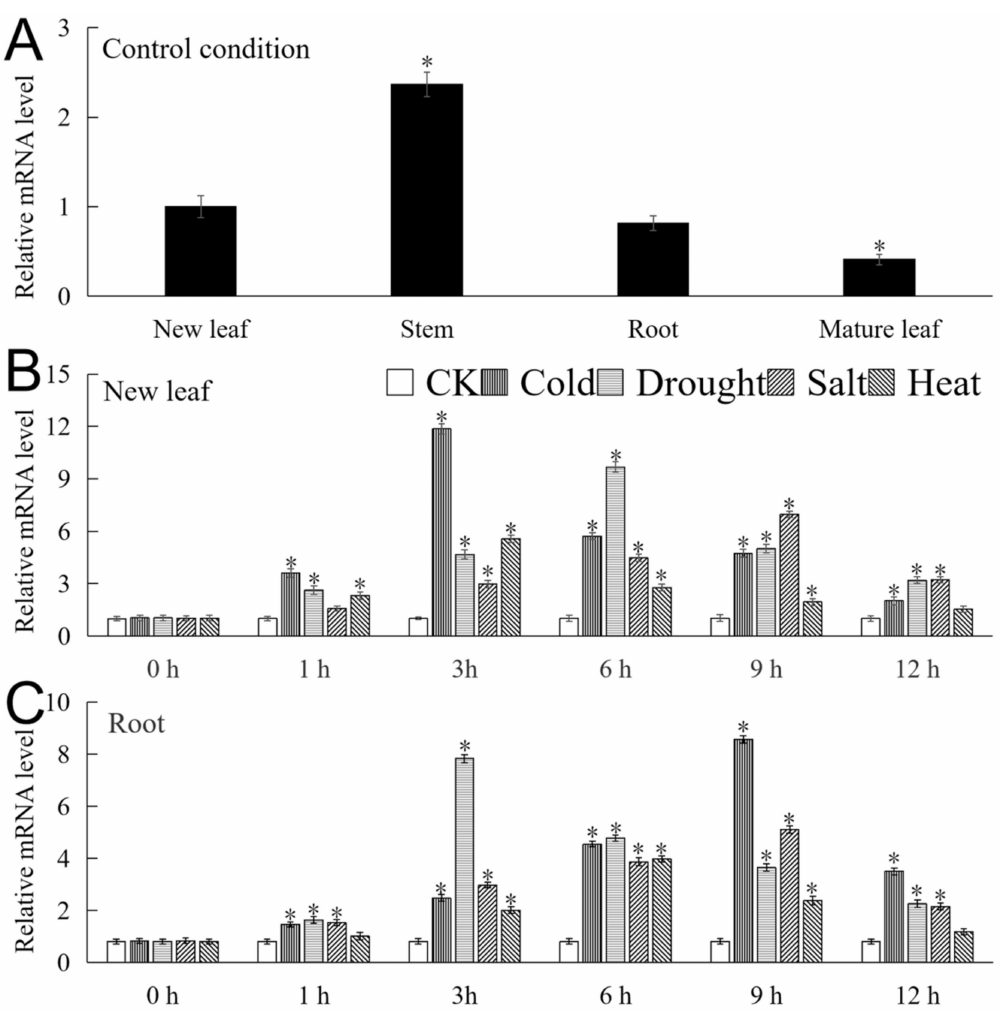
Figure 4. The expression of MbICE1 . ( A ) Expression of MbICE1 gene in different tissues of Malus baccata under normal growing conditions. The new leaf was selected as the control group. ( B ) The relative expression of MbICE1 gene in Malus baccata new leaf and ( C ) root under control conditions (CK, no stress treatment was performed) and stress conditions. The value is the average of three repeats, and the standard deviation is represented by the error bar. The asterisk indicates the difference between treatment and control conditions (* p ≤